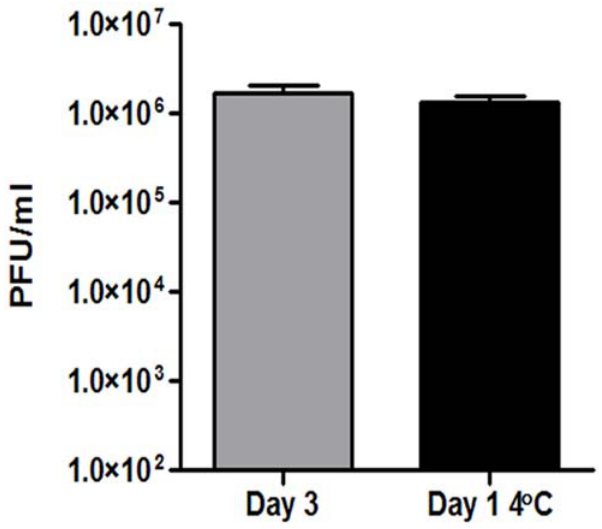
Figure 3. Survival of R.rickettsii after exposure to 4 u C for 24 hrs. R. rickettsii grown for three days was shifted to 4 u C for 24 hours after which PFUs were determined and compared to R. rickettsii grown for three days at 34 u